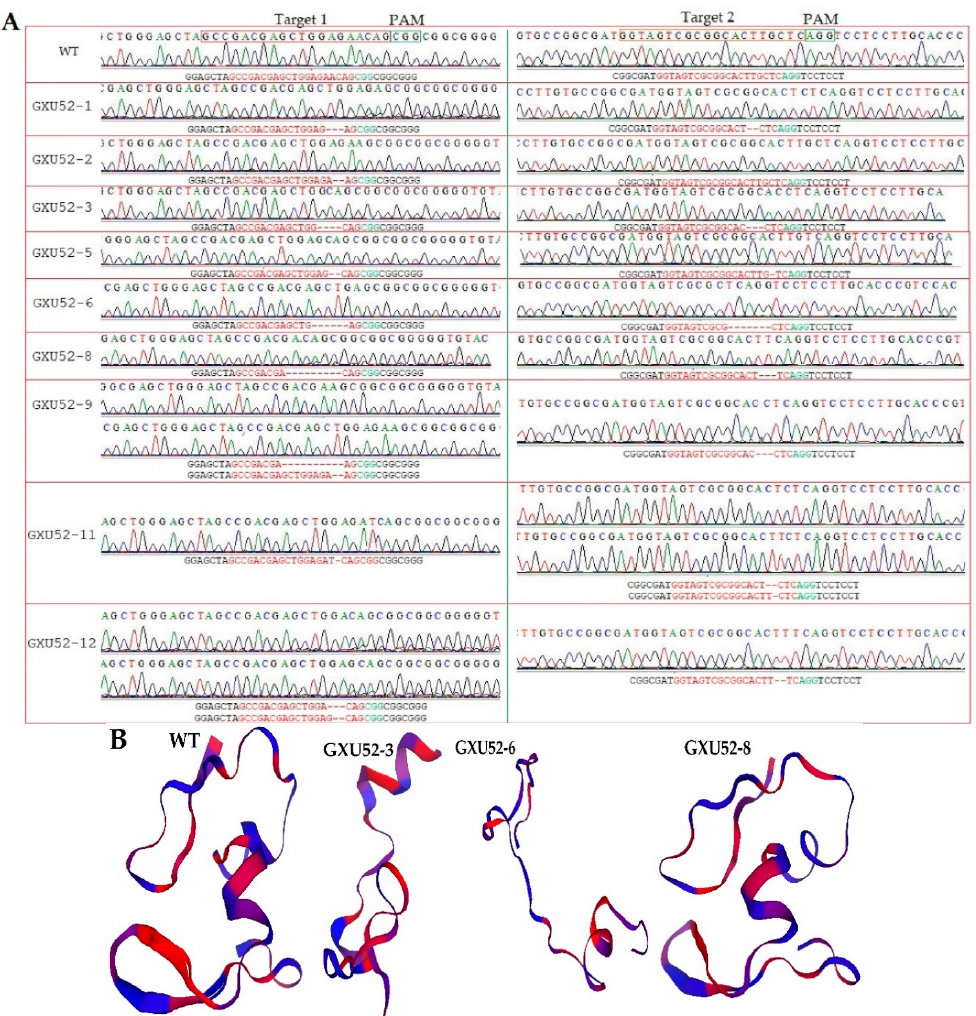
Figure 2. Sequence chromatograms and protein modeling of T 0 mutant plants. ( A ) Sequencing peaks for wild type (WT) and mutant plants. Base deletion and insertion are represented with “-” and purple letters, respectively. Red and green letters are the target regions and protospacer adjacent motif (PAM) sequence, respectively; ( B ) the three-dimensional protein structures of the WT and mutant lines.